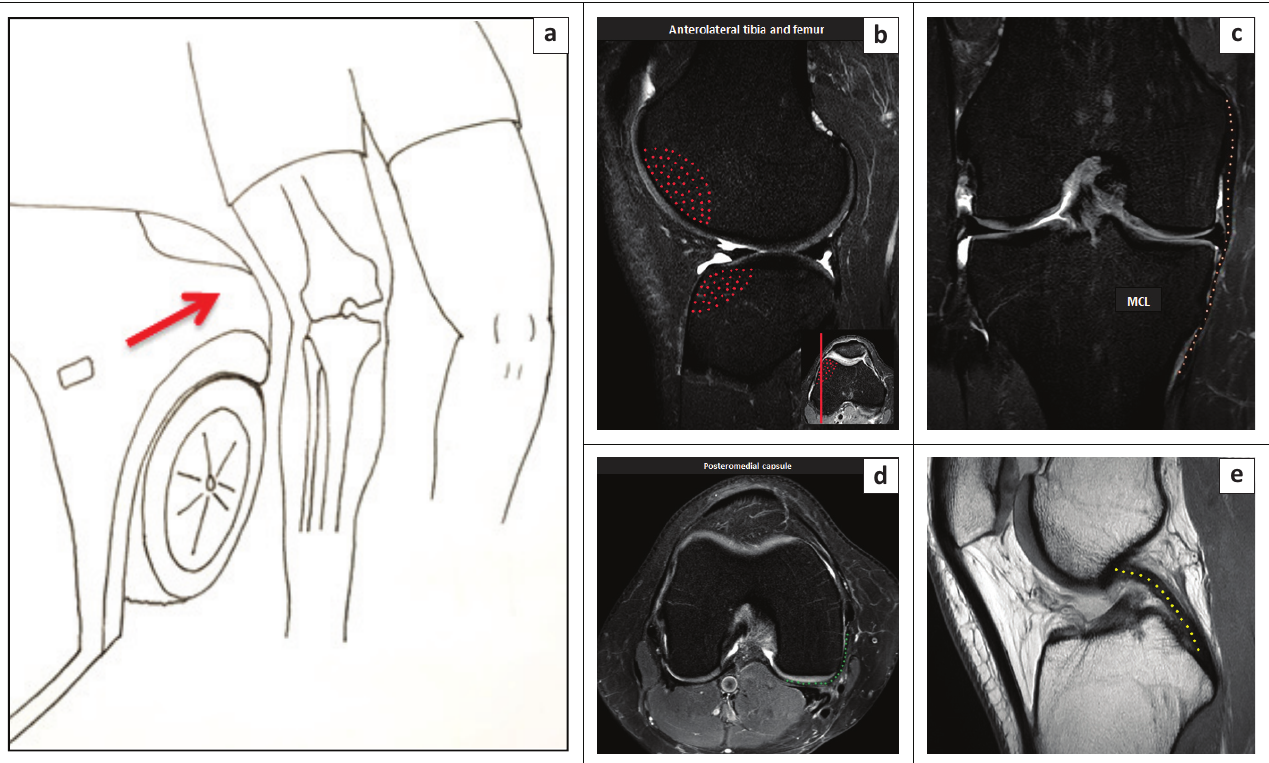
FIGURE 3: Hyperextension with valgus: (a) Schematic depicts anterolateral impact with posteromedial force, (b) contiguous right knee anterolateral tibia and femoral condyle impactions, (c) medial collateral ligament injury, (d) posteromedial capsular injury, where there may be posteromedial tibia avulsion bone oedema, and (e) depicts posterior cruciate ligament injury.